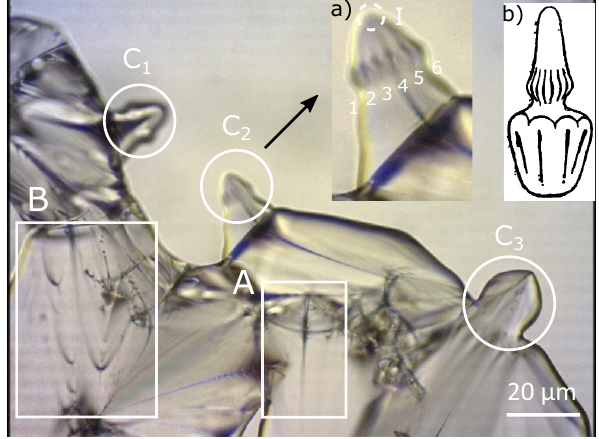
Figure 4. Polarized Optical Microscopy of 10CB: ( a ) Zoom in a certain region where bâtonnets are clearly visible; ( b ) bâtonnets’ model given by Friedel from